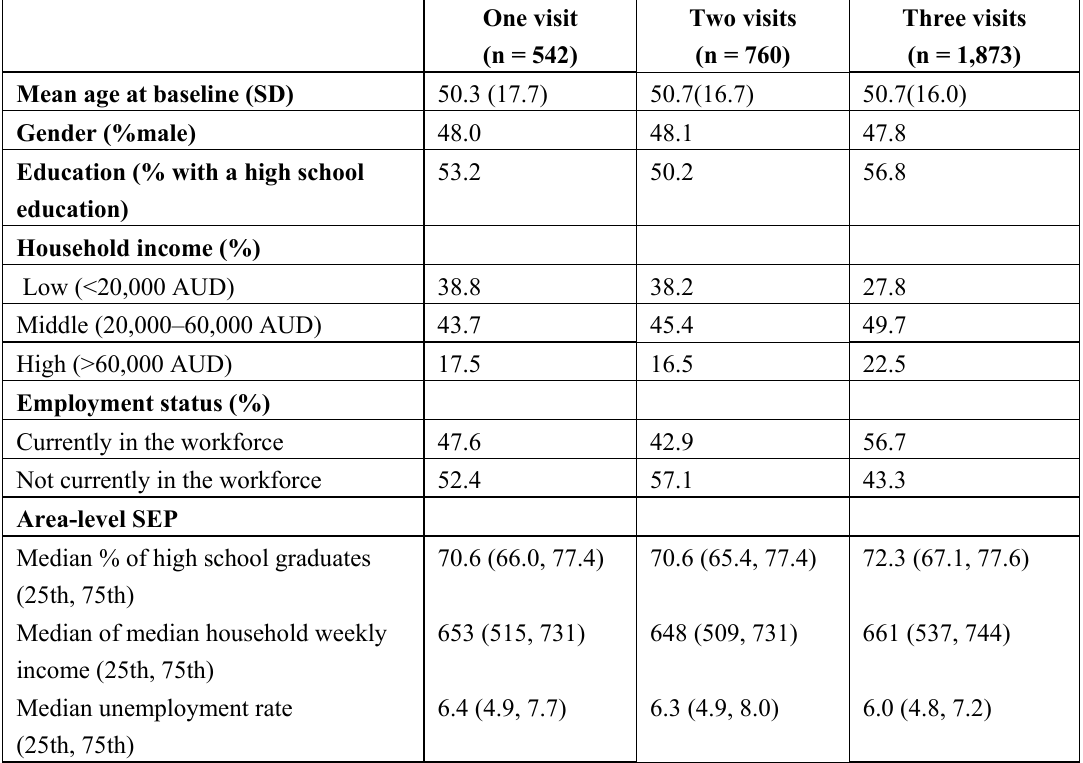
Table 2. Distribution of baseline variables by the number of clinical visits for which MetS status was